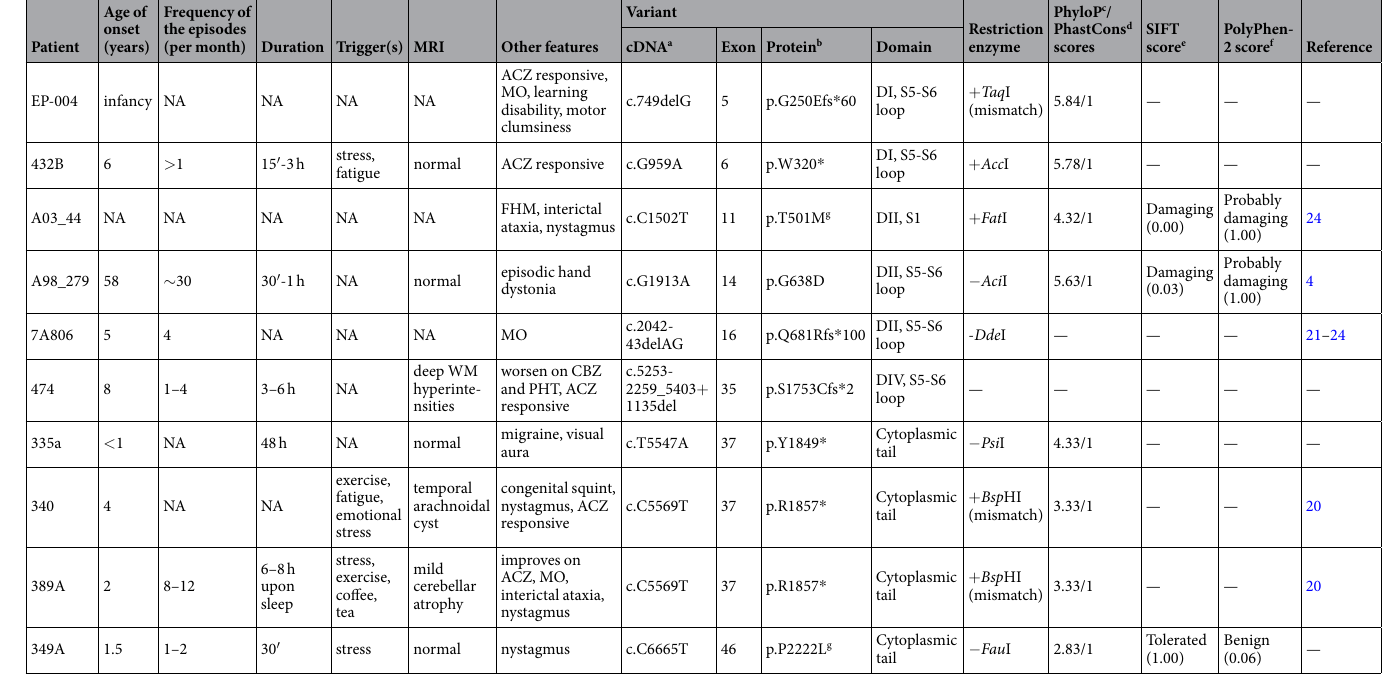
Table 1. Clinical information and results from the CACNA1A mutational screening in episodic ataxia patients with identified variants. MRI: Magnetic Resonance Imaging; NA: not available; ACZ: acetazolamide; MO: migraine without aura; FHM: Familial Hemiplegic Migraine; WM: white matter; CBZ: carbamazepine,; PHT: phenytoin; D: domain; S: segment. a Reference sequence for cDNA nomenclature: NM_001127221 (nucleotide c.279A corresponding to the initiation codon, ATG). b Rererence sequence for protein nomenclature: NP_001120693. c PhyloP score: Positive scores indicate sites that are predicted to be conserved, whereas